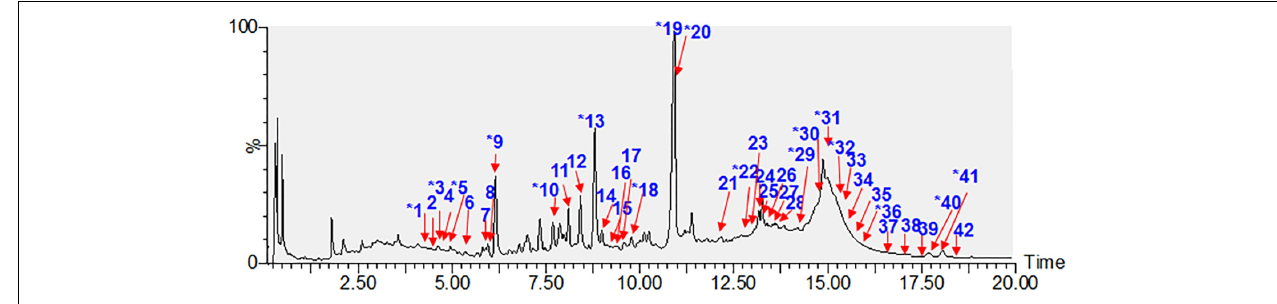
FIGURE 3 | LC/MS total ion currents of the water extract of Datura metel seeds (WDS). ∗ Identified by comparing with reference standards.